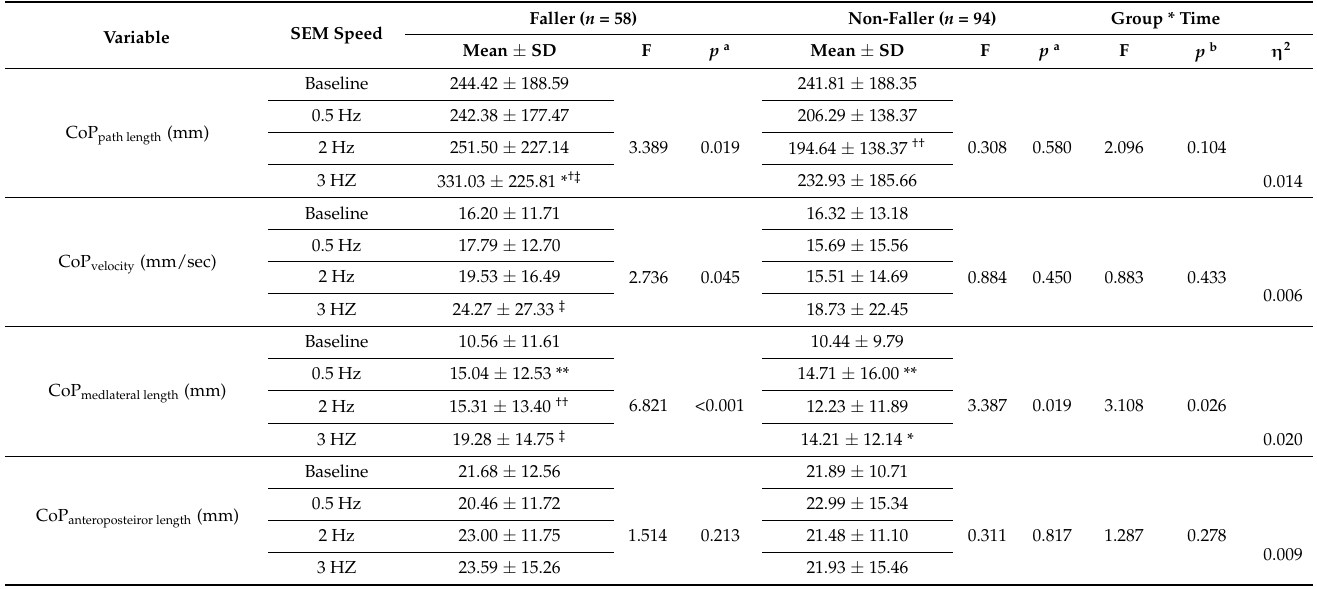
Table 2. Comparisons of postural sway between baseline and during 0.5, 2 and 3 Hz saccadic eye movement.